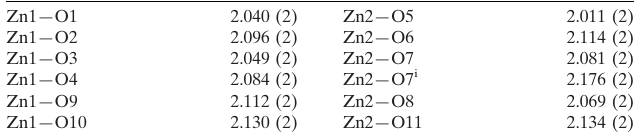
Selected bond lengths (A˚